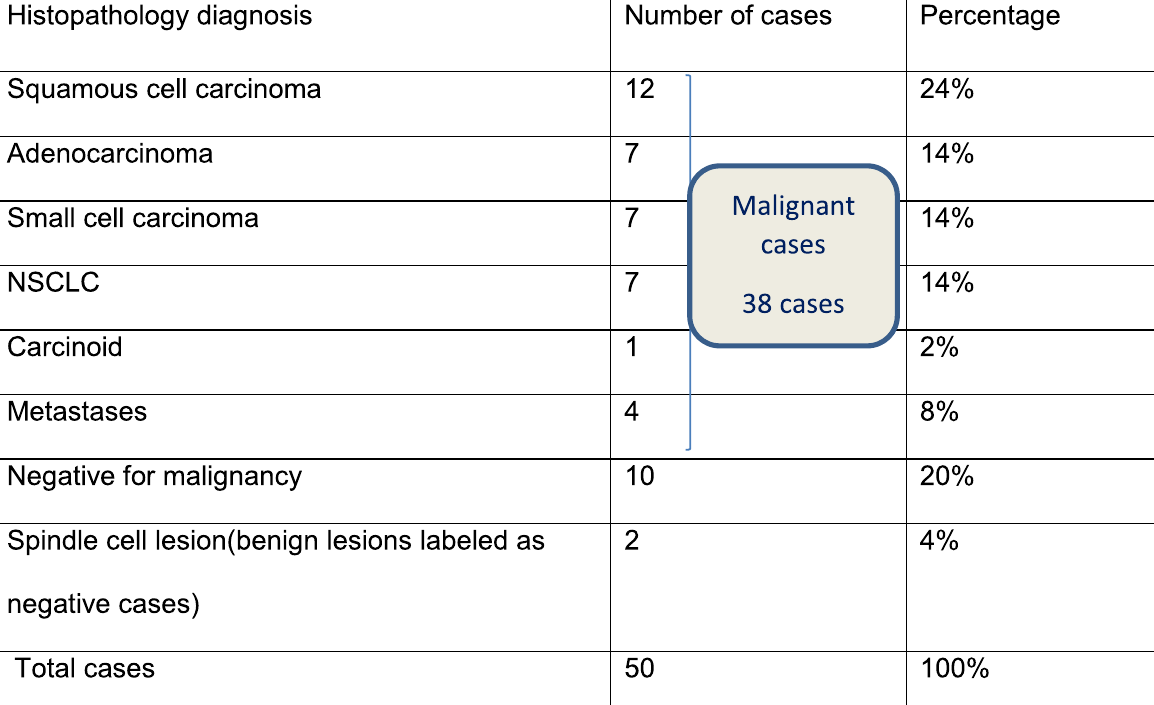
Table 3 Showing distribution of histopathological cases ( n